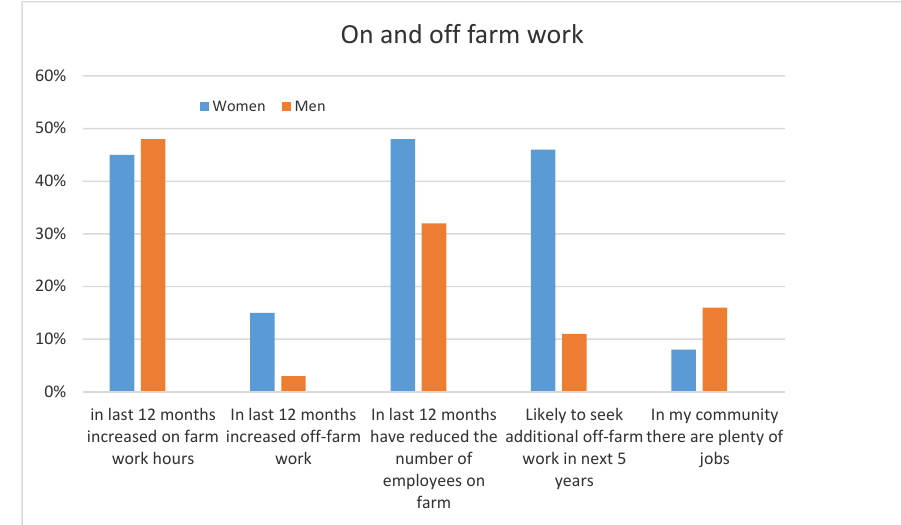
Figure 1. On- and off-farm work: reality and perceptions.